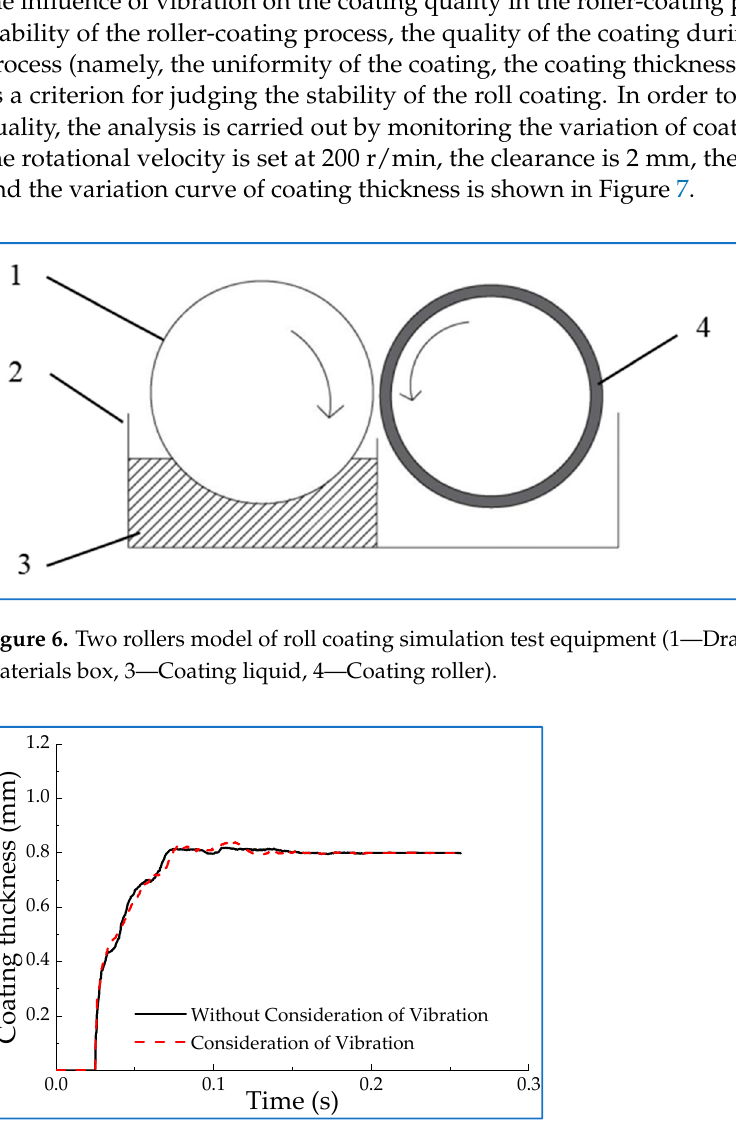
Figure 7. Contrast diagram of coating thickness affected by vibration.